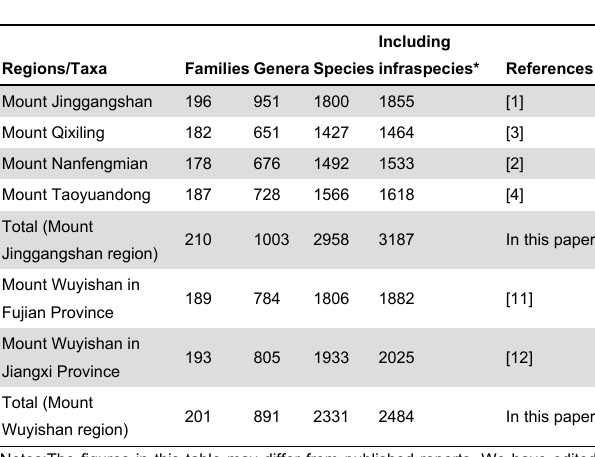
Table 1. Statistics of the seed plants in Mount Jinggangshan region and Mount Wuyishan region.